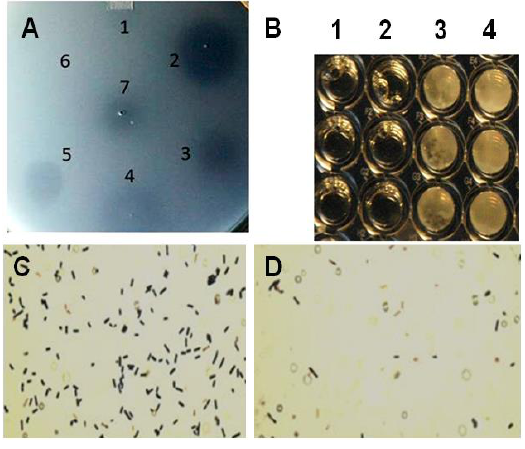
Figure 2. Plate lysis, minimal inhibitory concentration and Gram-stain of lytic enzyme treated Clostridium perfringens